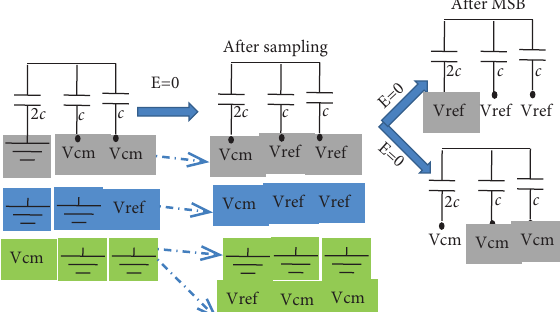
-based capacitor switch. CM